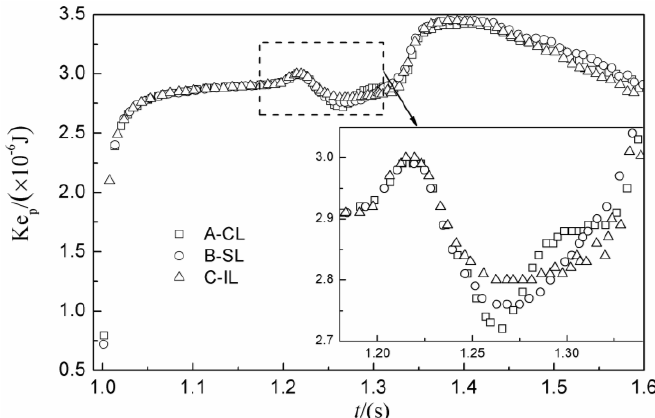
Figure 12. Effects of Cr on particle turbulent kinetic energy.